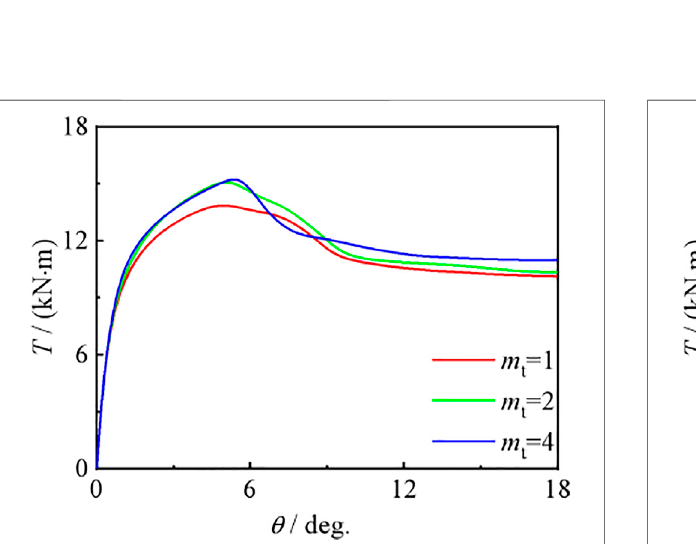
FIGURE 23 | m t effect on the T – θ curve of the compression torsion member.